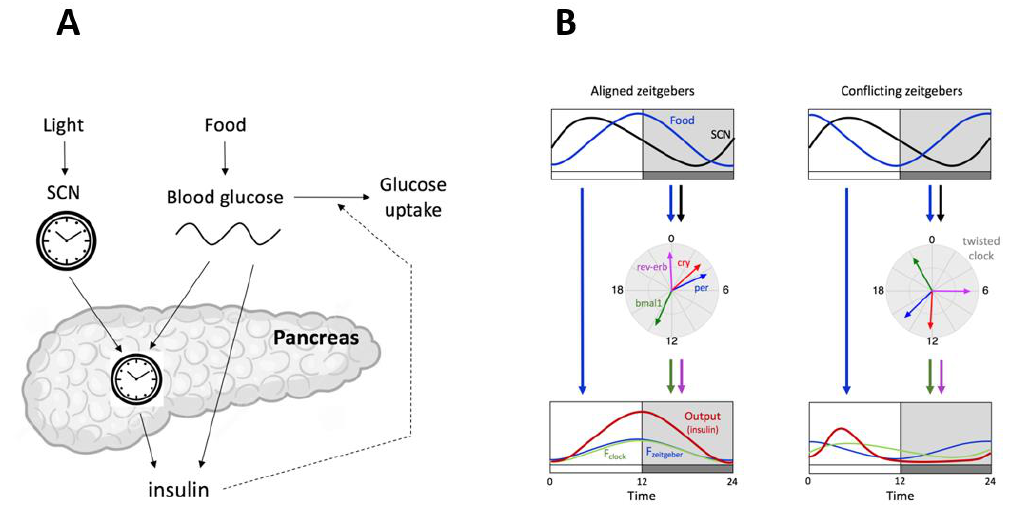
Figure 3. ( A ) Scheme of the model proposed by Woller and Gonze [86]. The release of insulin by the pancreas is controlled by the pancreatic circadian clock and by the level of circulating glucose, the latter being directly dependent on feeding. The pancreatic clock is controlled both by the light-dependent SCN clock and by the blood glucose. ( B ) Summary of the results obtained with the model [86]. In normal conditions, when light and food cues are aligned, the clock optimally mediates the response so that the output (insulin) reaches a high level when needed to store glucose. Under conflicting conditions, the expression of clock genes is altered (twisted clock), and this translates into an impaired output (phase shifted and low level of insulin rhythm and hyperglycemia).